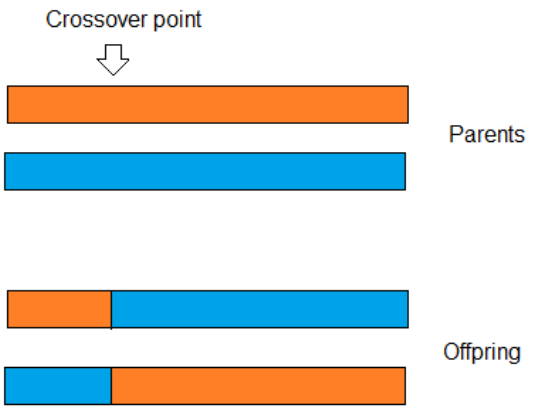
Figure 4. Illustration of the crossover